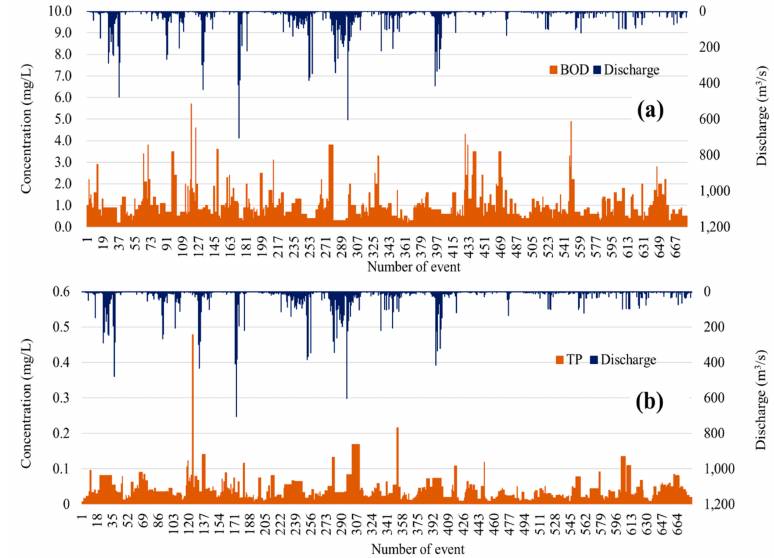
Figure 6. Variation in pollution concentration and discharge during the period of study: ( a ) Biochemical Oxygen Demand (BOD); ( b ) Total Phosphorous (TP).